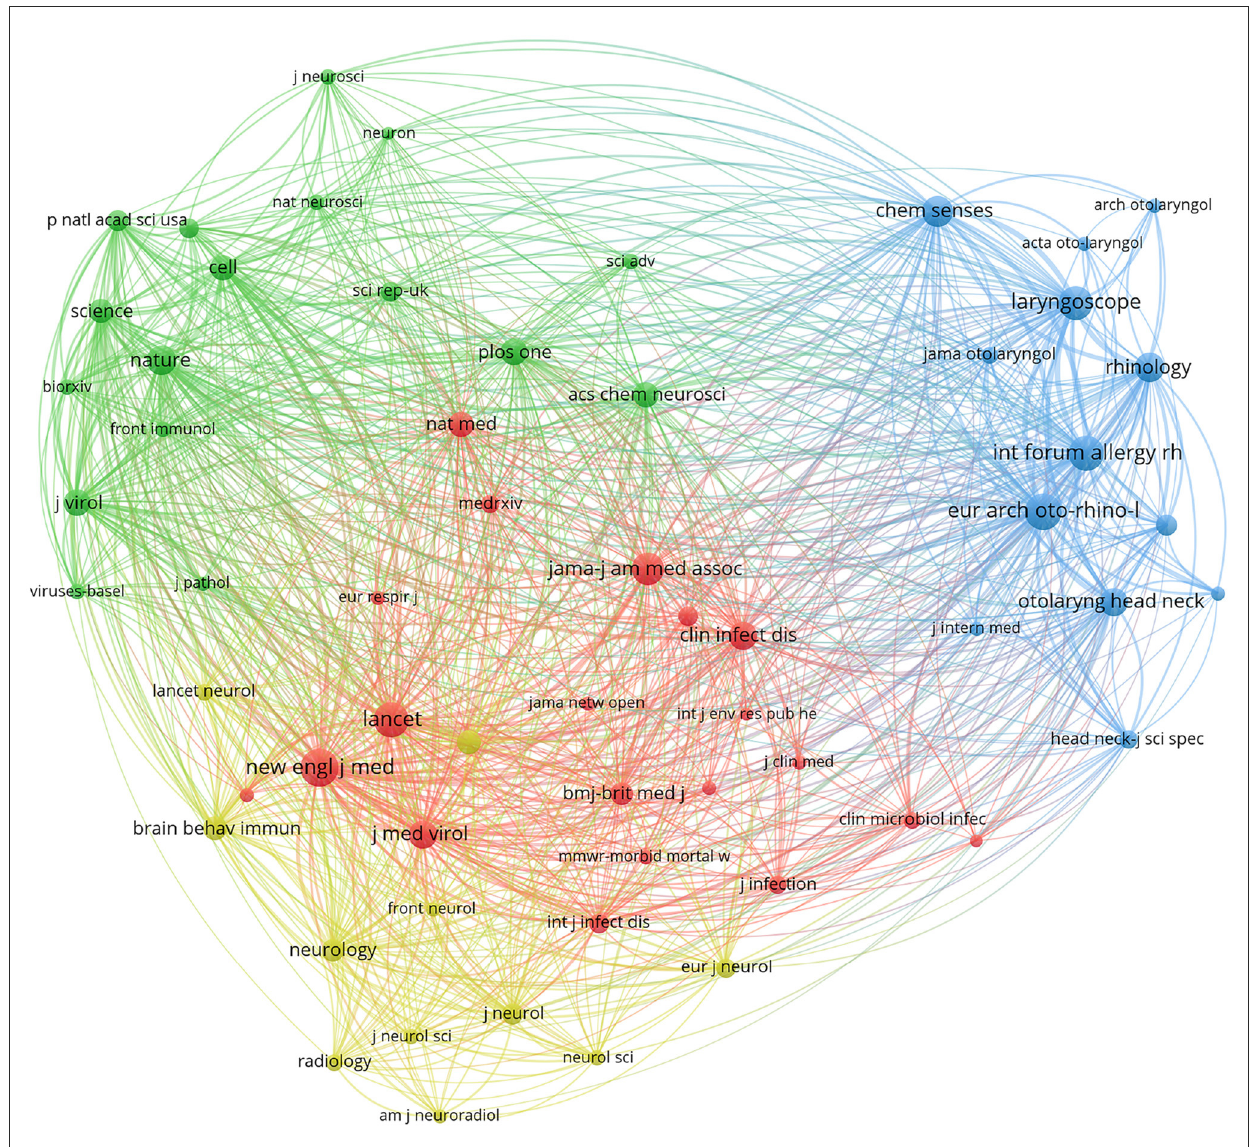
FIGURE2 The mapping of cited sources co-citation analysis.